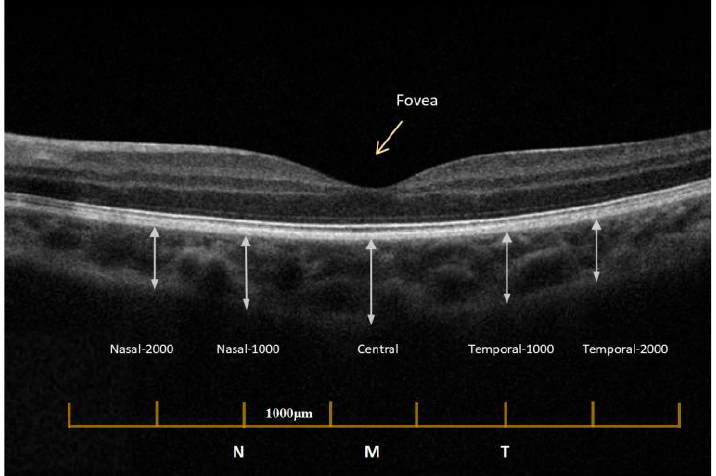
Figure 1. Choroidal imaging with EDI-OCT mode. EDI-OCT, Enhanced deep imaging optical coherence tomography. RPE, retinal pigment epithelium layer.